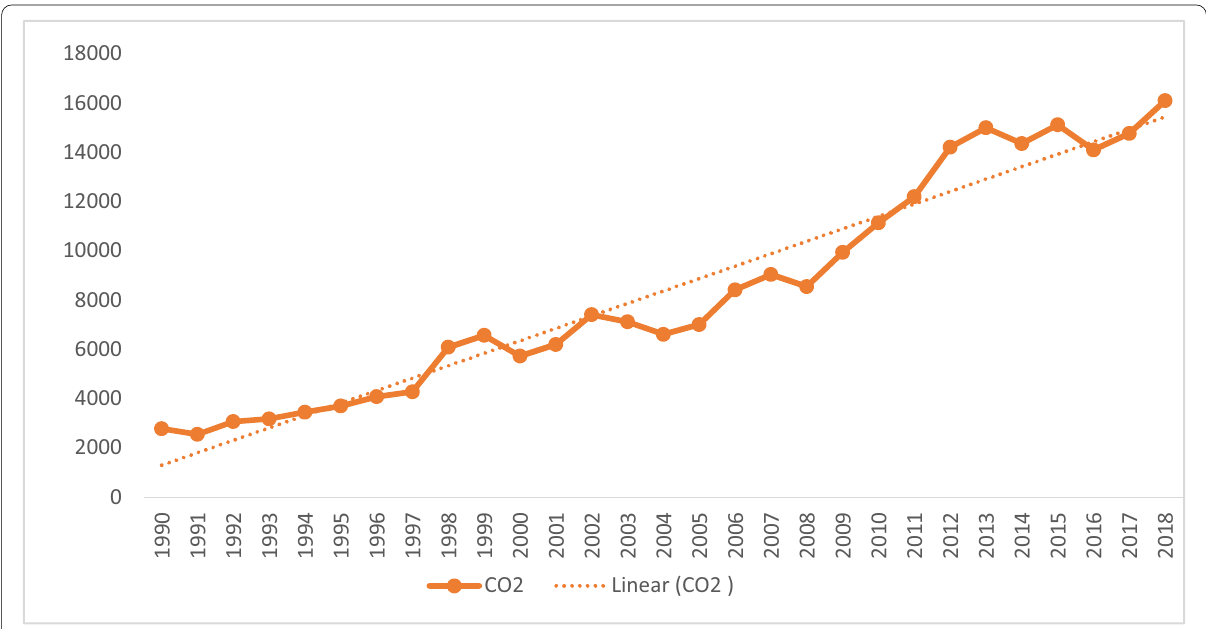
Fig. 1 Trend of CO 2 emissions in Ghana. Source: Authors’